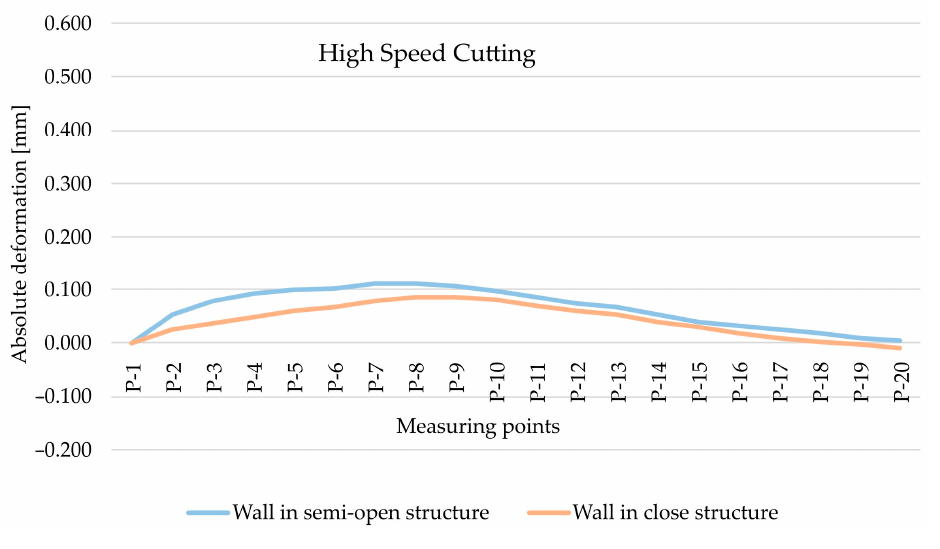
after conventional cutting. This is consistent with the results obtained for the EN AW-7075 Figure 12. The comparison of absolute deformation for individual measurement points depending T651 on the geometry of the thin-walled sample for HSC and for the EN AW-6082 T651 aluminium alloy.